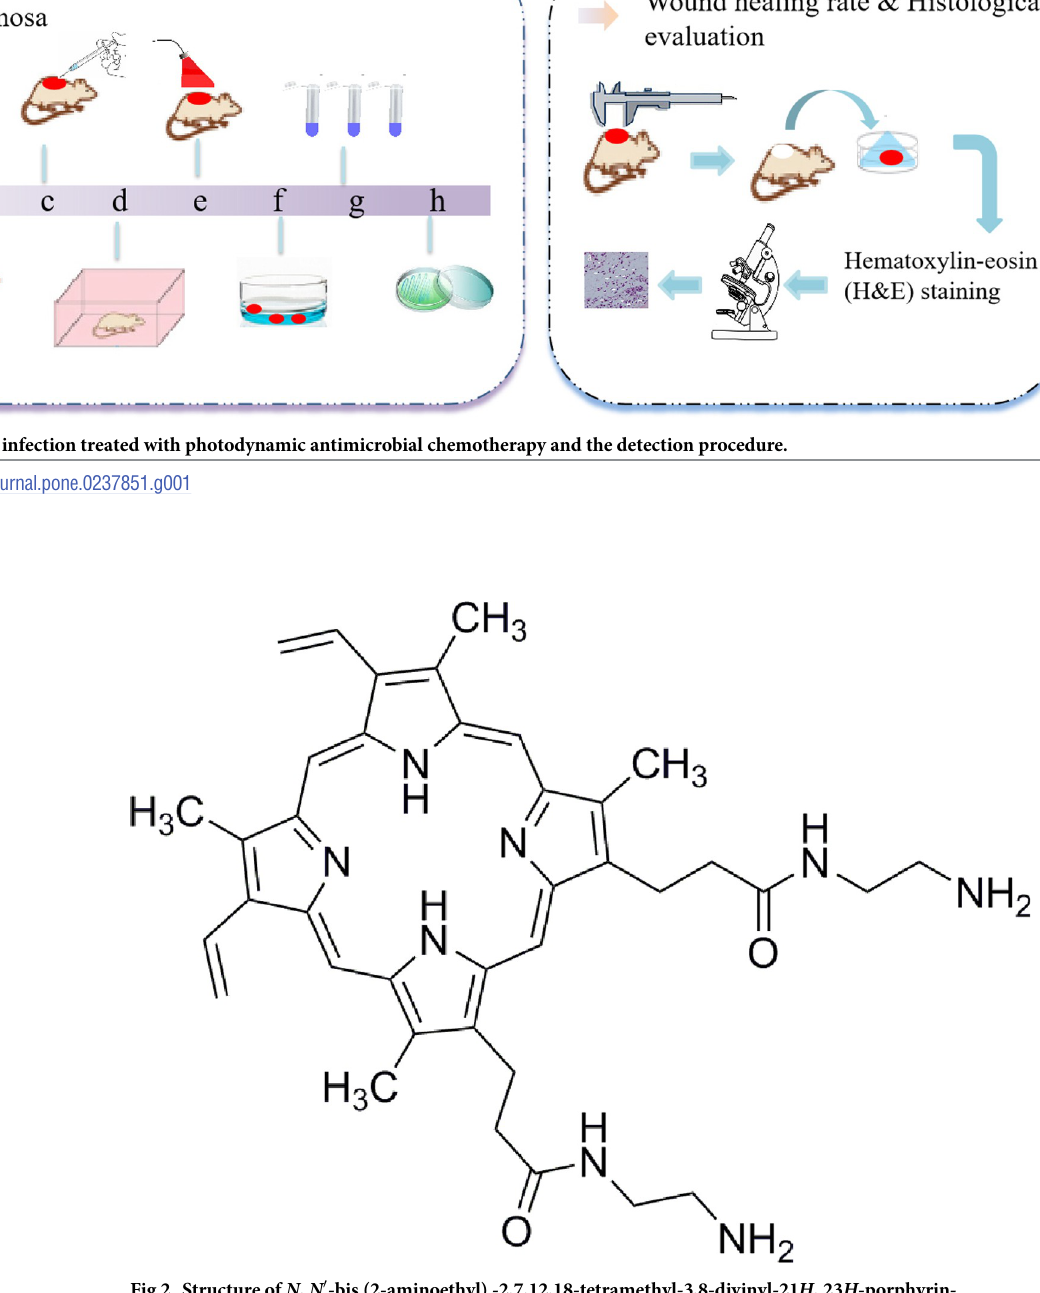
PLOS ONE | https://doi.org/10.1371/journal.pone.0237851 September 2,